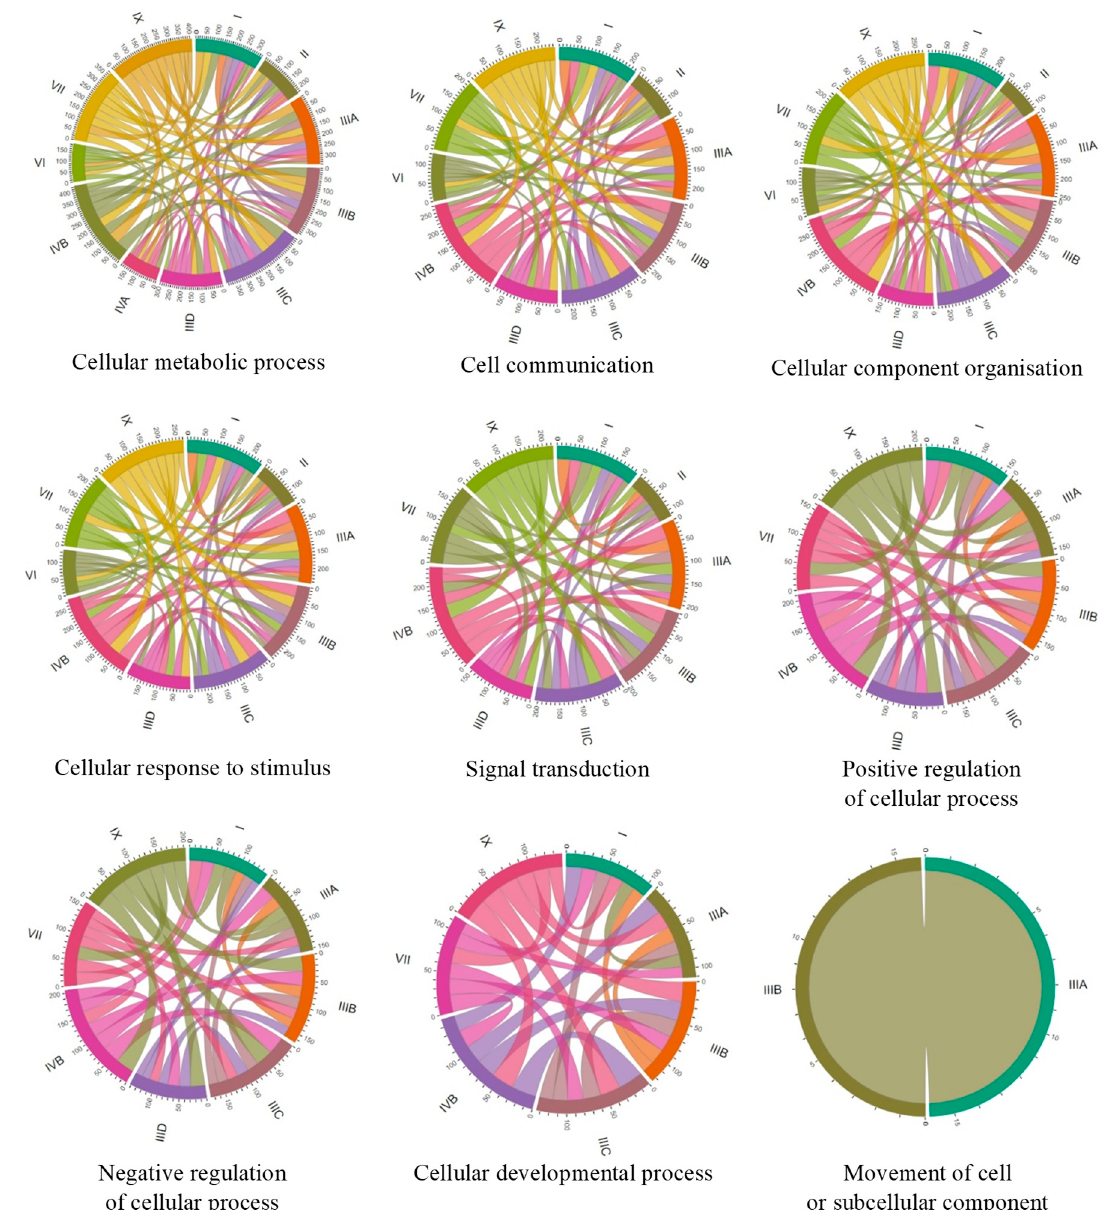
Figure 4. Chord diagrams indicating numbers of common genes between individual MPS types for which expression is particularly strongly changed (FDR < 10 − 6 , p < 0.1) relative to control cell (HDFa line). Individual panels group genes involved in indicated cellular processes. Roman numbers indicate corresponding MPS types.